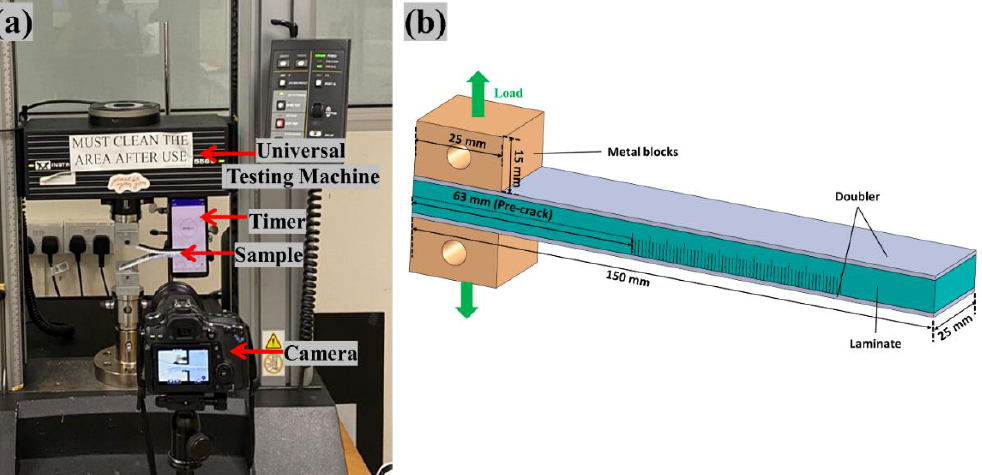
Figure 3 . ( a ) Mode I test setup ( b ) Schematic of Mode I sample with doublers and metal block attached .